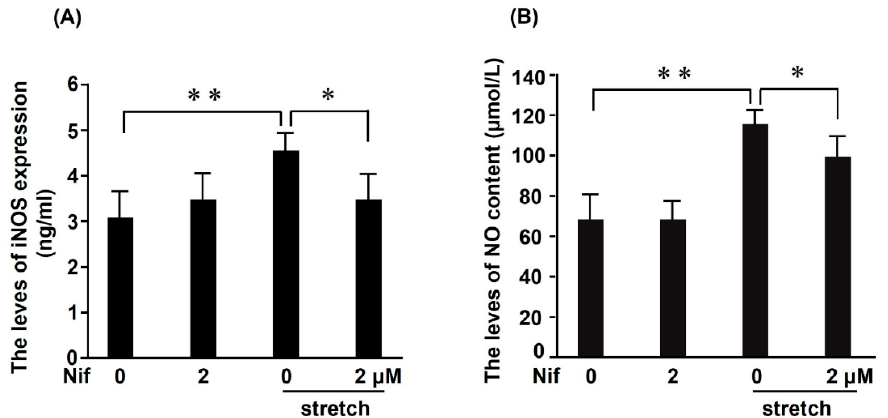
Figure 6. Effects of signal transducers and activators of transcription 1 (STAT1) inhibitor on iNOS protein expression and NO production induced by CMS in RASMCs. RASMCs were incubated with a STAT1 inhibitor (nifuroxazide; Nif) at the indicated concentrations for 1 h and then incubated under normal conditions or subjected to CMS for 4 h. After CMS, the cells and medium were harvested, and iNOS protein expression (ng/mL) and NO production ( μ mol/L) were evaluated by ELISA ( A ) and the NO colorimetric assay ( B ), respectively. Data are presented as the mean ± SD ( n = 9); * p < 0.05 and ** p < 0.01 versus the CMS control.